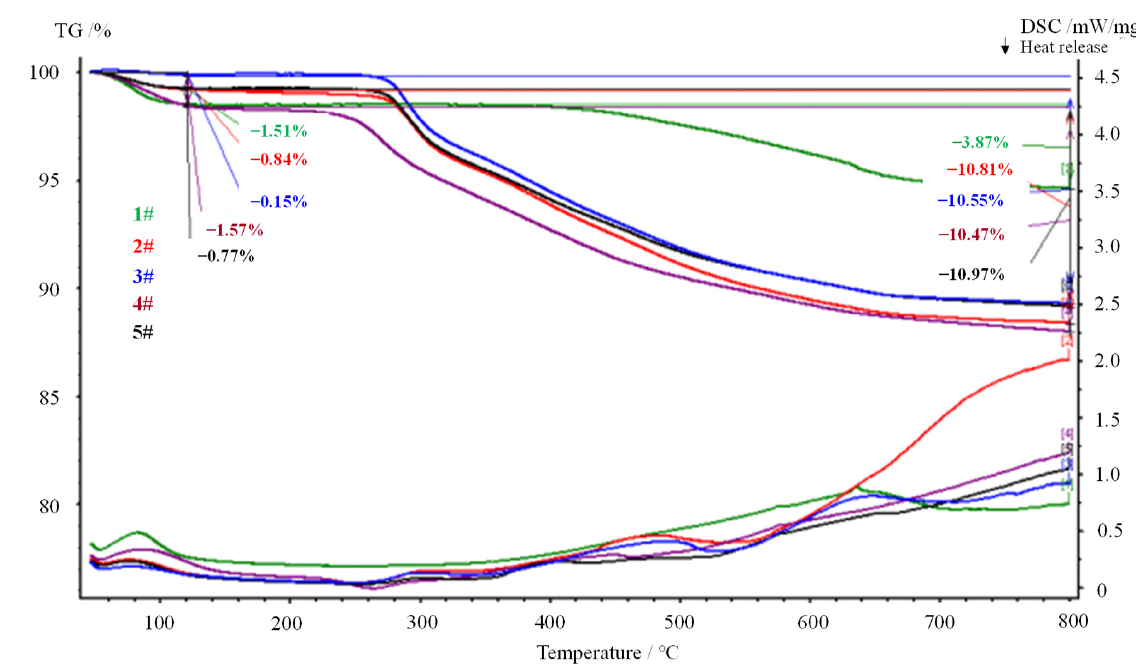
Figure 1. Thermogravimetric curves of polyamine inhibitors.